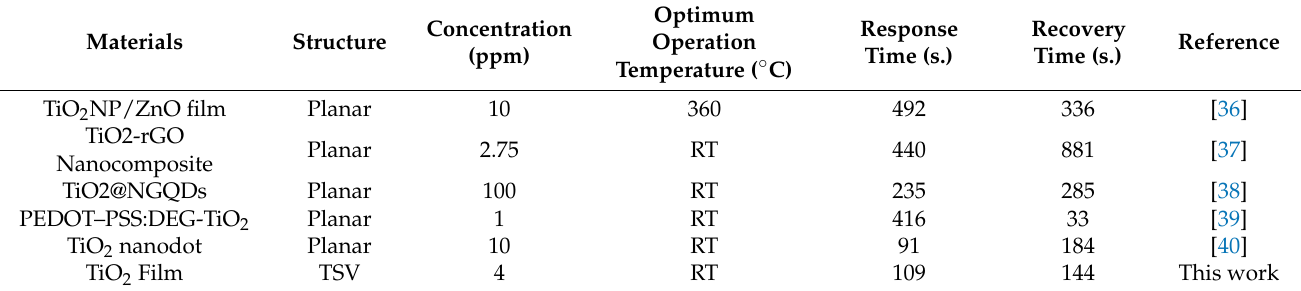
Figure 9. Gas measurements for a TSV-structured TiO 2 gas sensor.